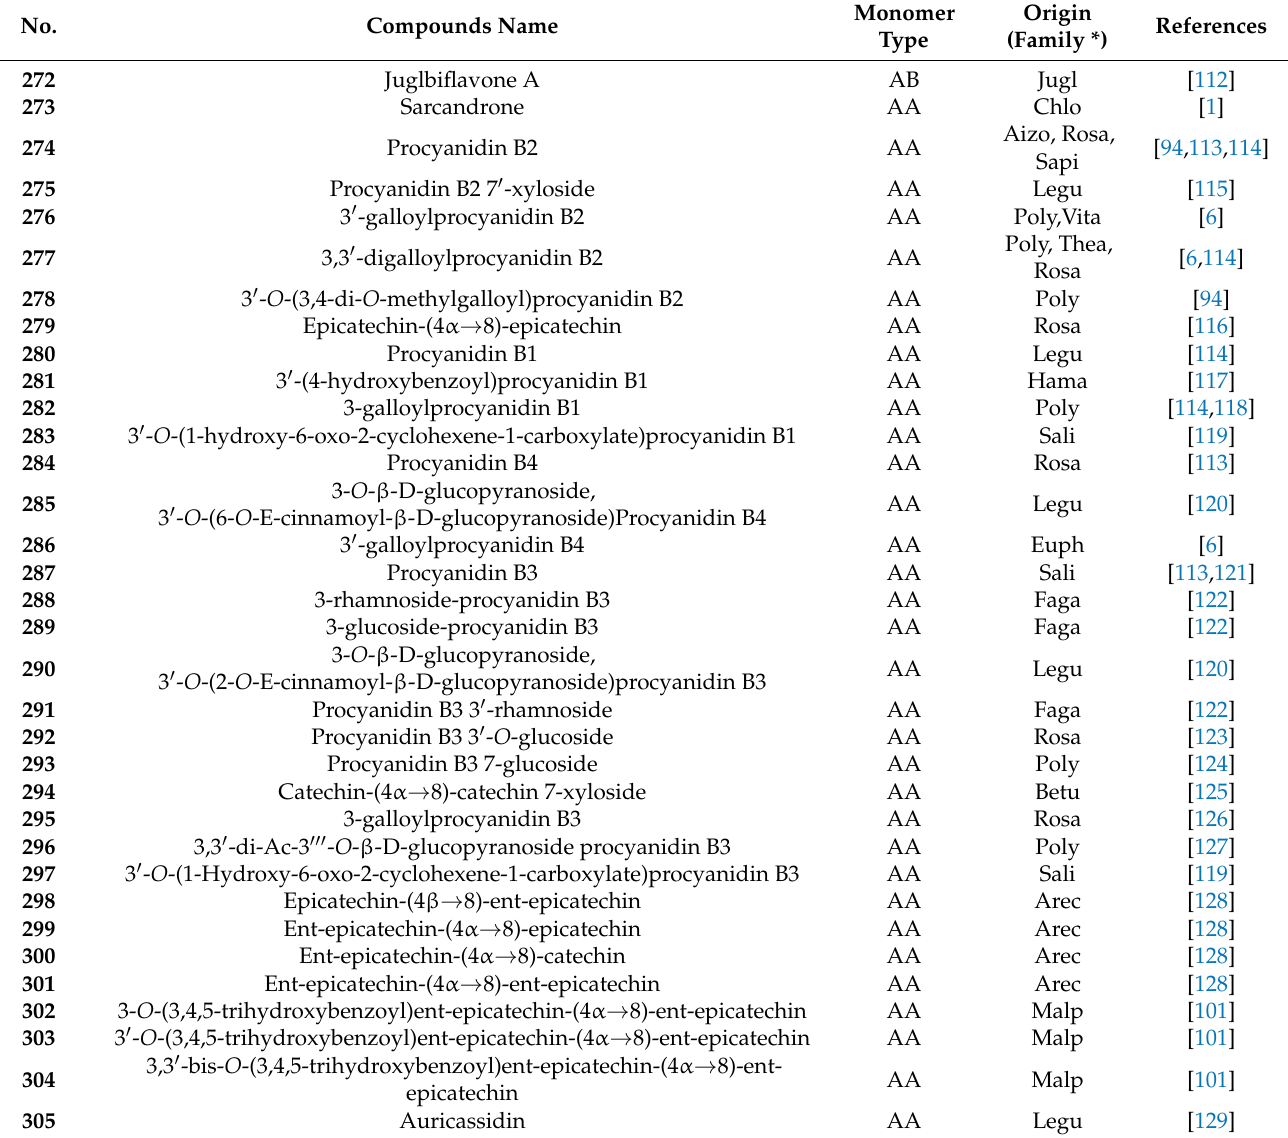
Table 6. The 4-8 (cid:48)(cid:48) subtype of